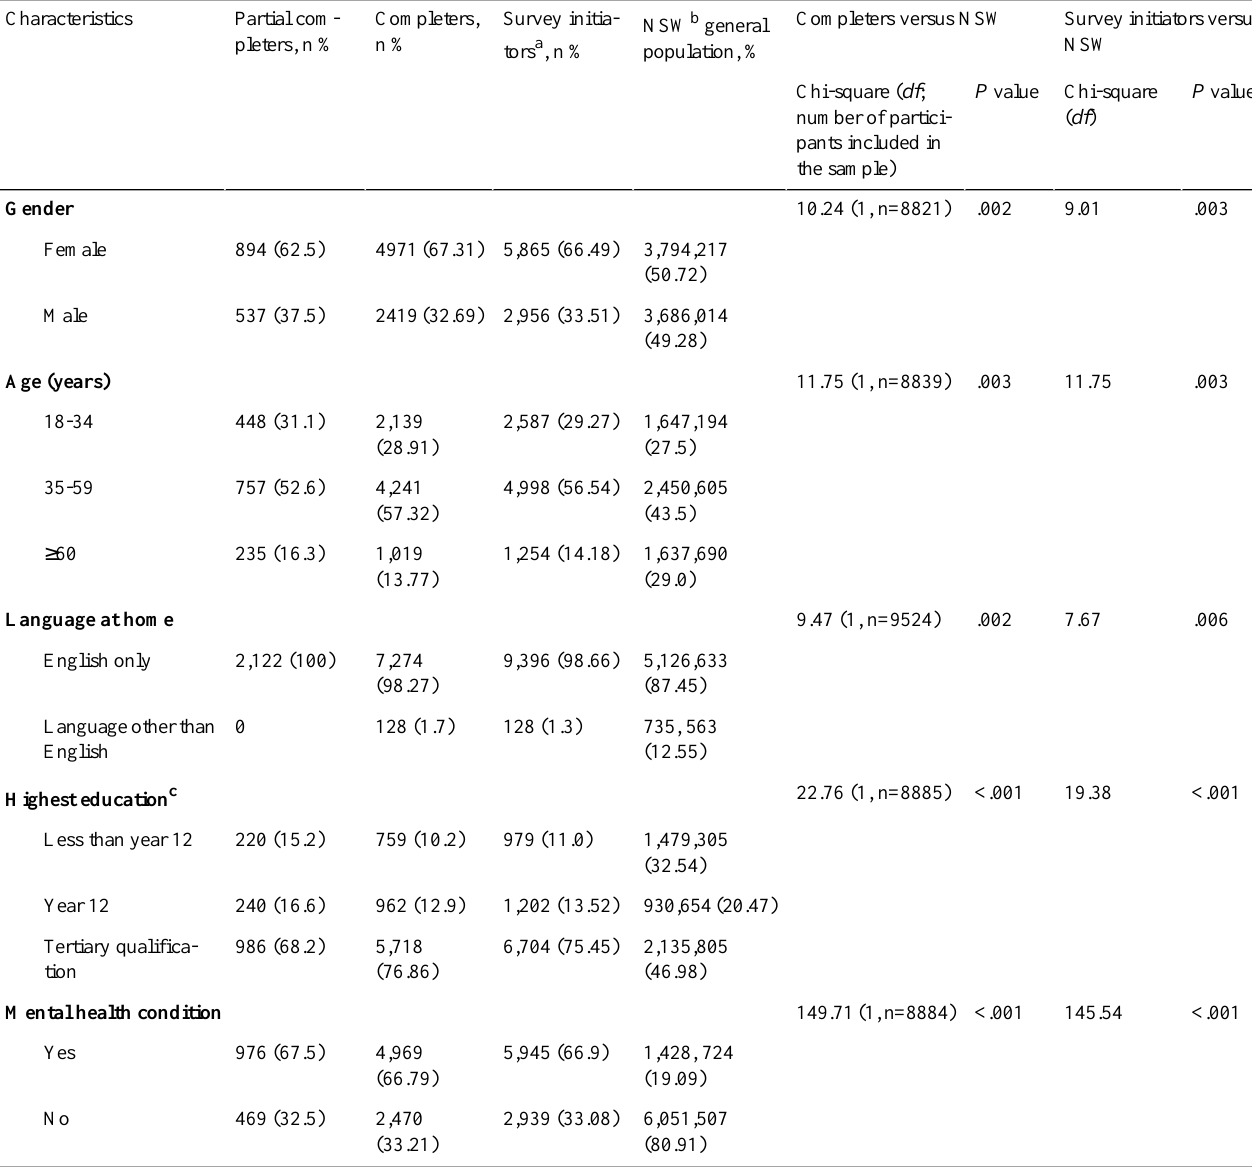
Table 3. Demographic and mental health characteristics of survey respondents compared with those of the New South Wales general population.